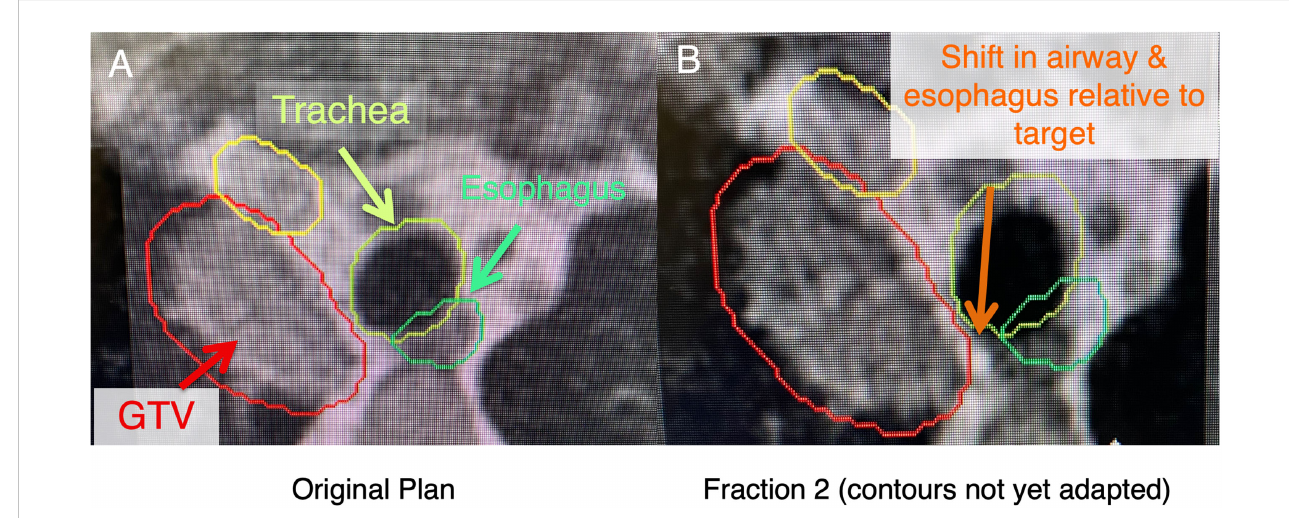
FIGURE 2 In these ultracentral locations, there may a shift of anatomy secondary to setup uncertainty and movement of nearby critical organs (i.e., esophagus), which may lead to an unacceptably high dose to these critical organs. (A) shows a patient with an ultracentral lung cancer at MR-simulation. (B) shows a shift of the esophagus and trachea relative to the tumor before contours are adapted (changed to the anatomy of the